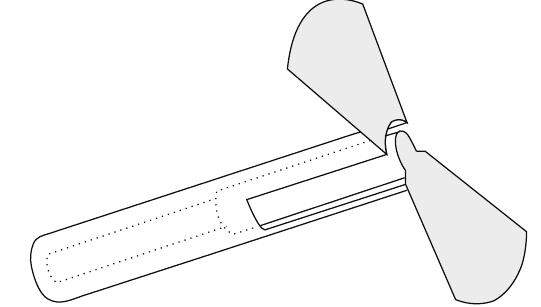
Figure 3: Split coaxial balun feeding a bowtie antenna (balanced load) through a coaxial line (unbalanced transmission